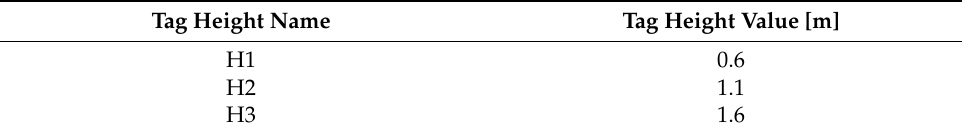
Table 2. Tag vertical placement in the UGV’s coordinate